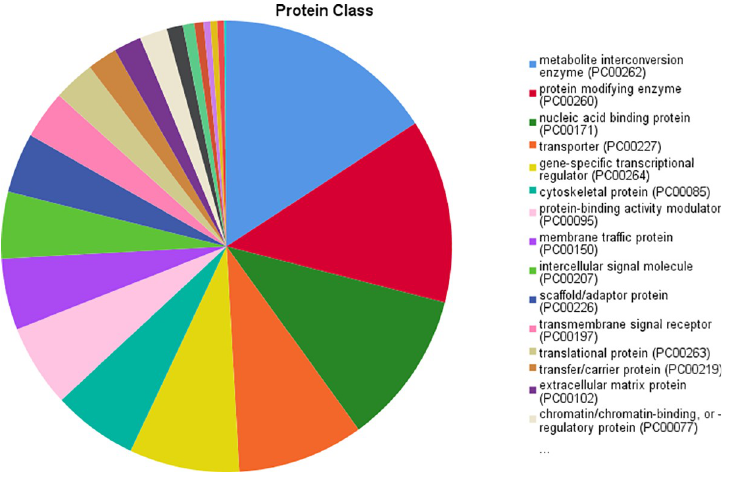
Fig 5. Results of “protein class”